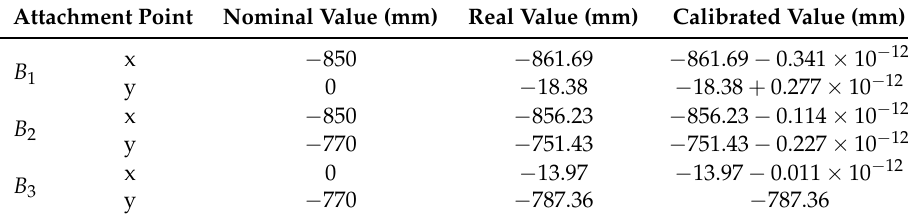
Table 1. Nominal, real, and calibrated coordinate values of the attachment points.